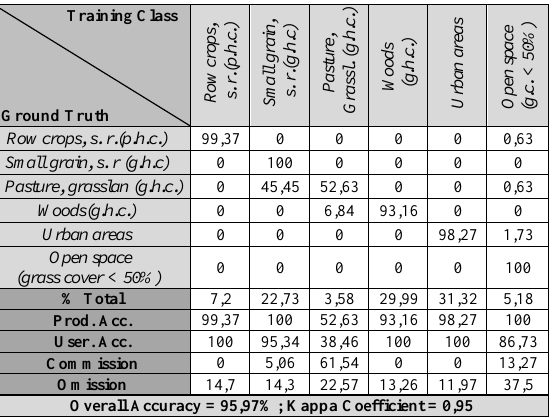
Table 1. Accuracy assessment of the MLC classification Training Class